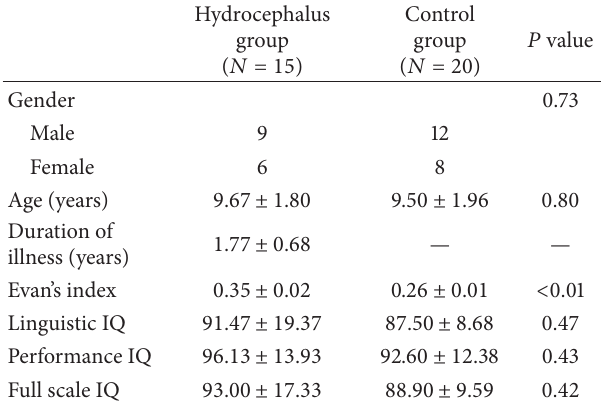
Table 1: Demographics and IQ of two